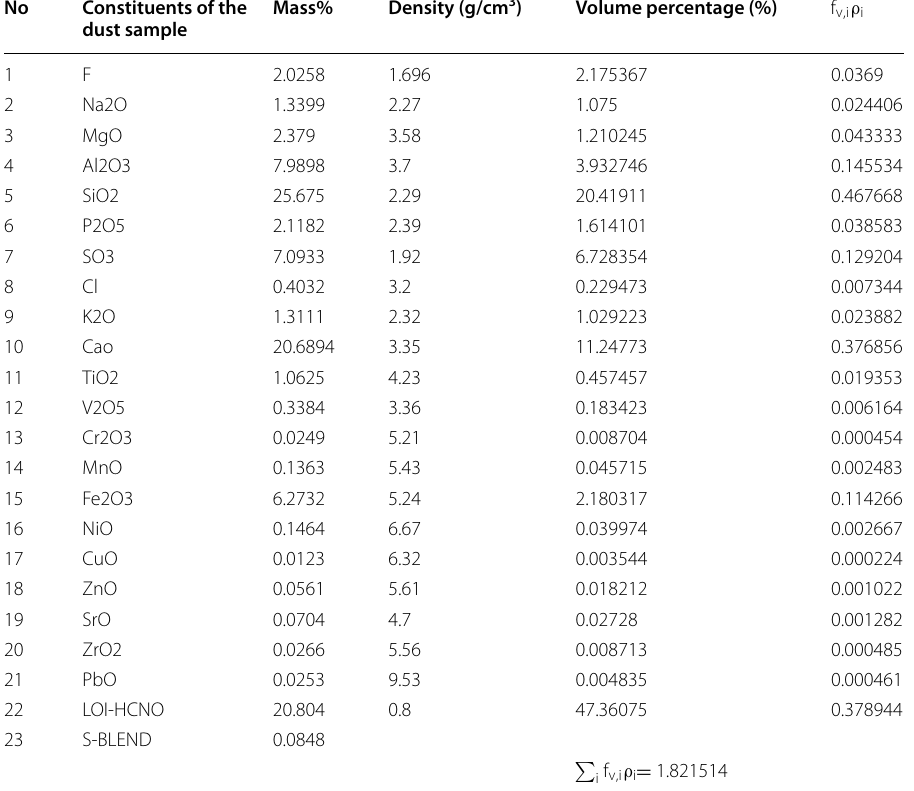
Table 3 Conversion of mass percentages into volume fractions of the main constituents of the dust to serve in calculating the density of the dust